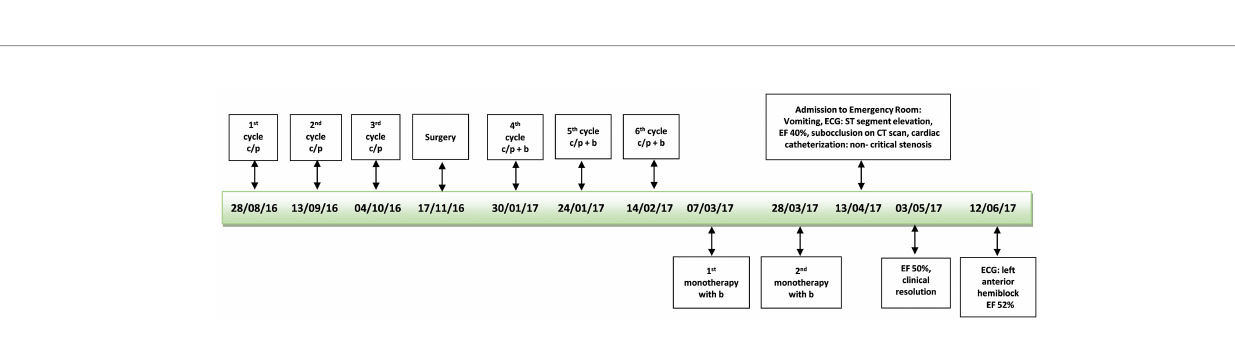
FIGURE 2 | Time line fi rst patient. c/p , carboplatin/paclitaxel; b , bevacizumab; ECG , electrocardiogram; EF , ejection fraction.